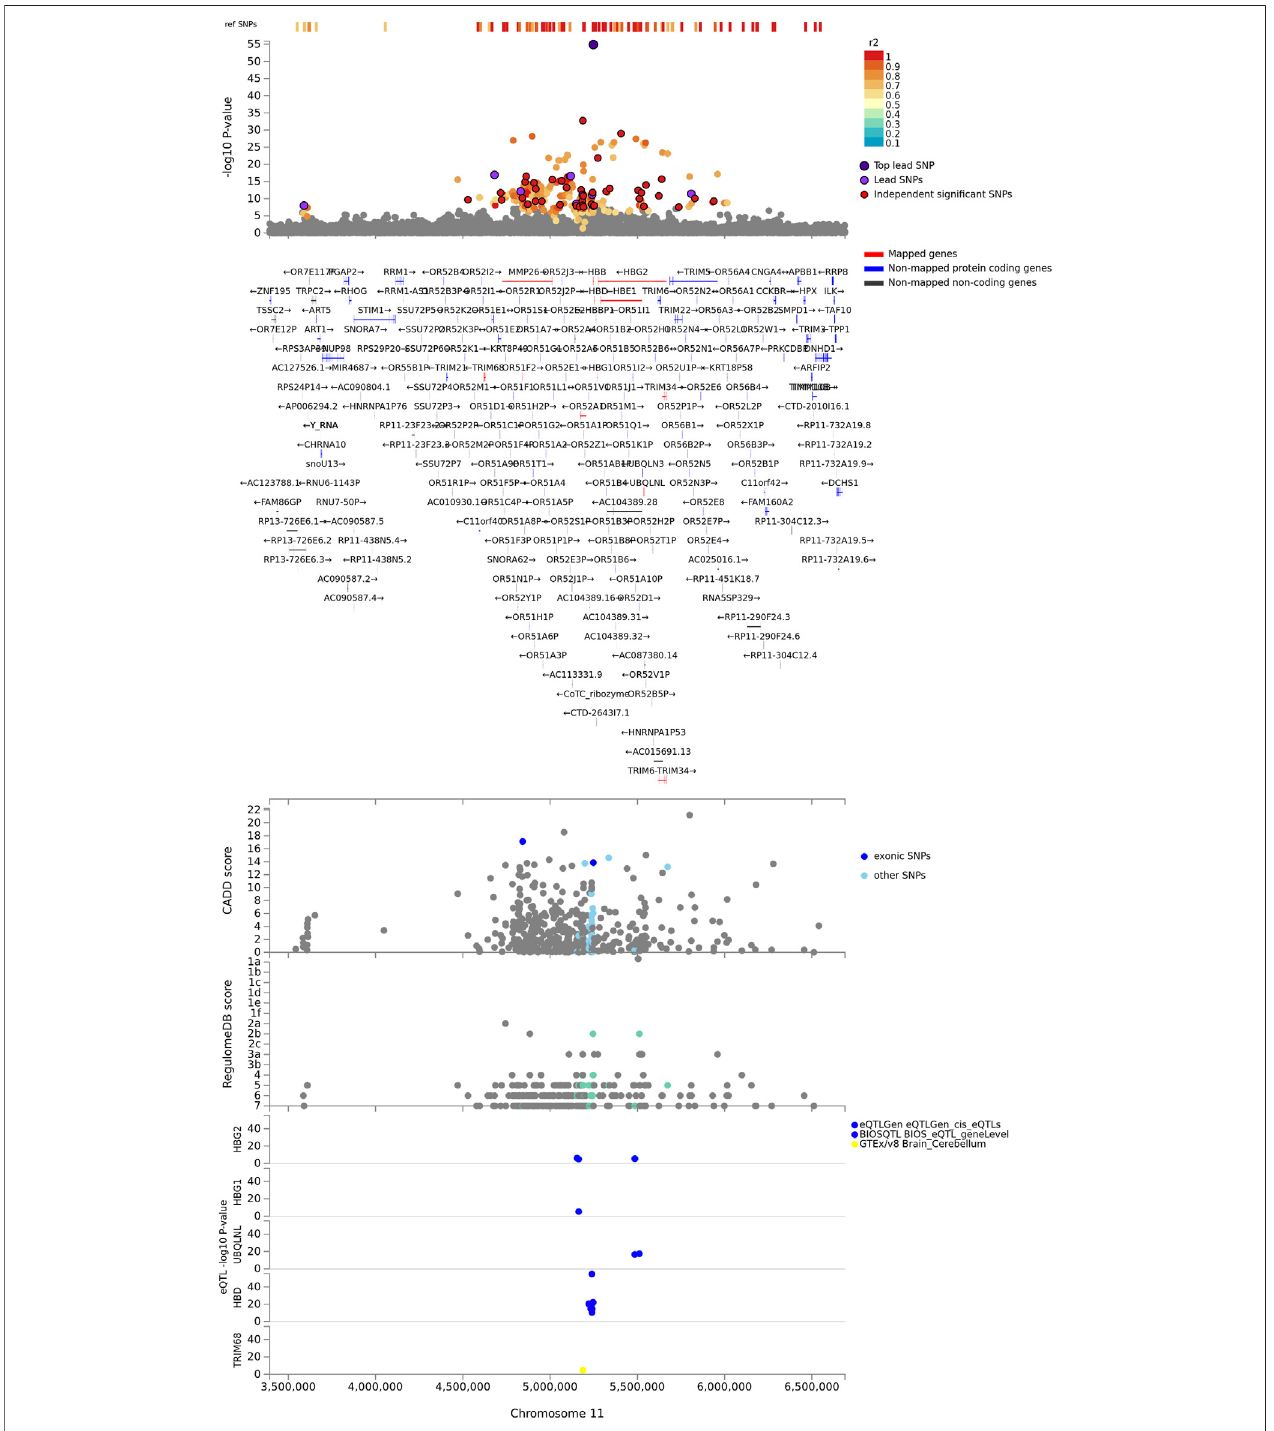
FIGURE2| RegionalplotofseveremalariasusceptibilityGWASlocusonchromosome11.Non-GWAS-taggedSNPsareshownatthetopoftheplotasrectangles sincethey do not have a p -value from the GWAS. Prioritized genes arehighlighted inred. eQTLs areplotted per geneand coloured basedon tissuetypes. CADD score, RegulomeDB score, and eQTLs, SNPs which are not mapped to any gene are coloured grey.